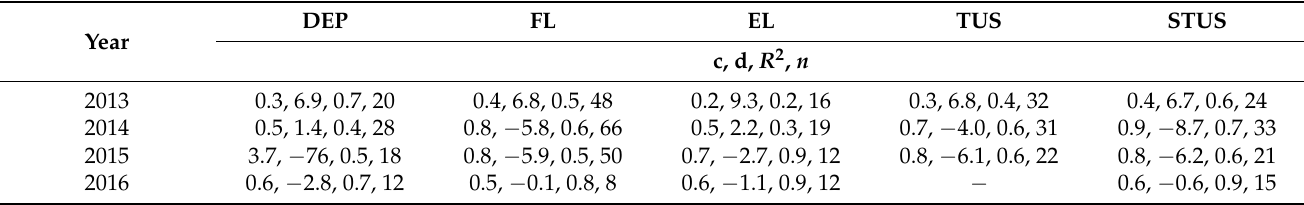
Table 1. Regression equation coefficients and statistical characteristics of calculation of seasonal dynamics of soil tempera- ture T soil (cid:48)